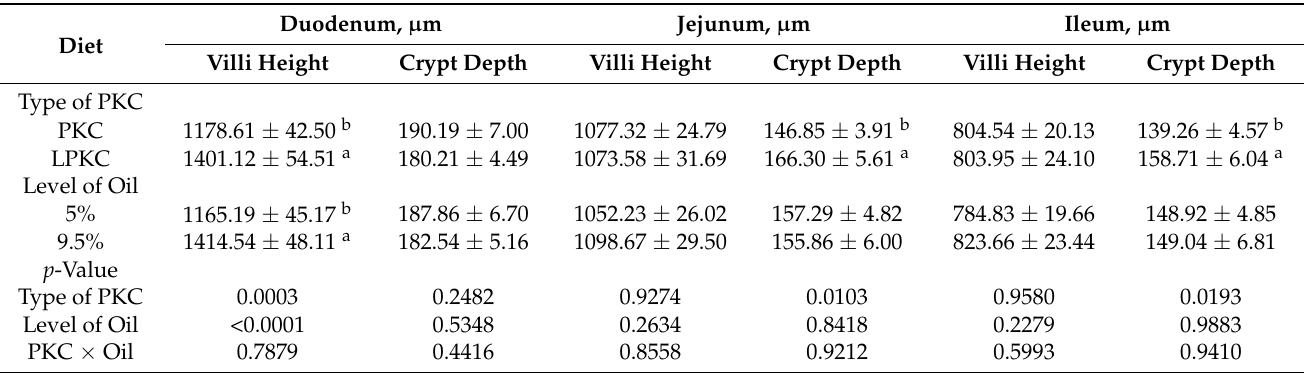
Table 6. Intestinal villi height and crypt depth of broilers fed LPKC and PKC-based diets at different levels of oil (Mean ± SE).